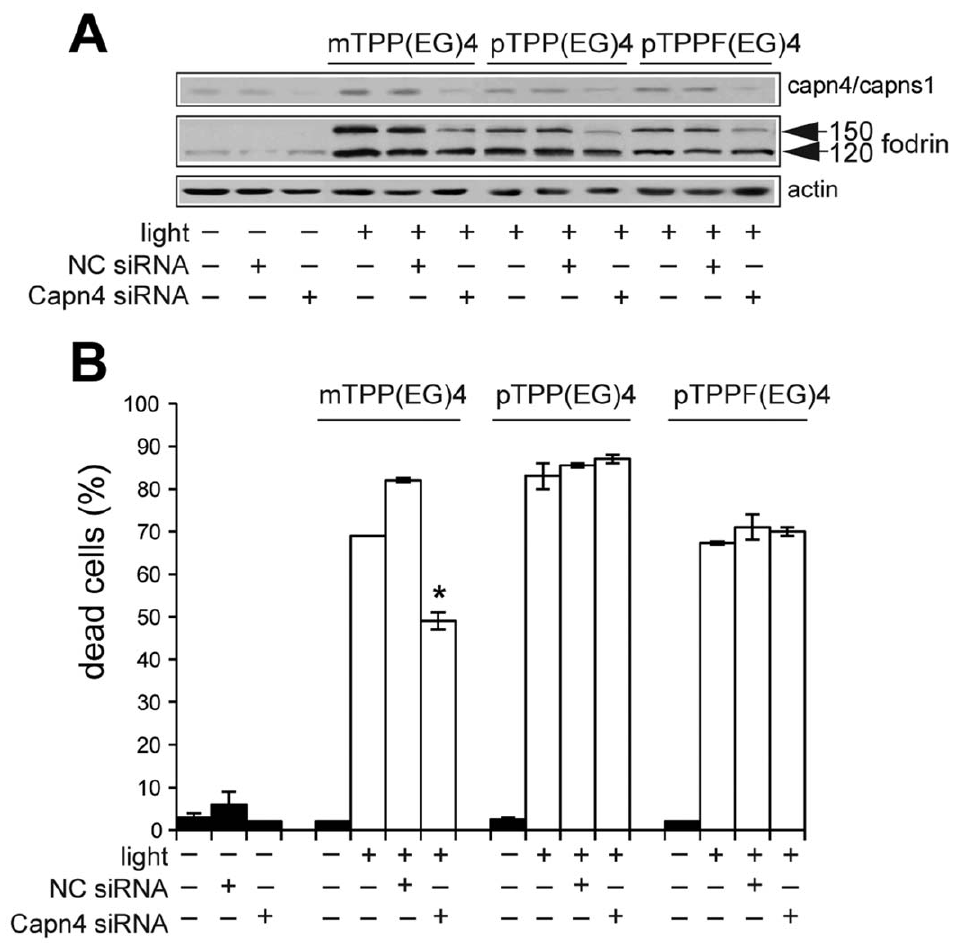
Figure 7. Effect of Capn4 siRNA on the demise of PDT-treated cells. ( A ) Western blot analysis of capn4/capns1 and fodrin in 4T1 cells analyzed on the 3 rd day after Capn4 siRNA transfection. Transfected cells were subjected to EG-porphyrin-mediated PDT, harvested and resolved by Western blot analysis. Equal protein loading is demonstrated by actin reprobing. ( B ) Viability of cells transfected with Capn4 siRNA. Transfected and control cells were subjected to EG-porphyrin-mediated PDT and cell viability was monitored 24 h later. The percentage of dead cells was expressed as the mean 6 SD (n=3). *P , 0.05 represents the statistical difference between transfected PDT-treated cells vs. non-transfected or control siRNA- transfected PDT-treated